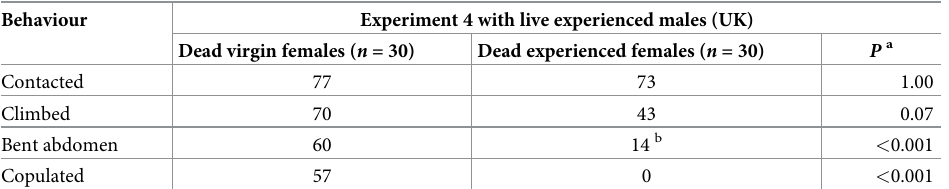
Bent abdomen 60 14 b < 0.001 Copulated 57 0 <